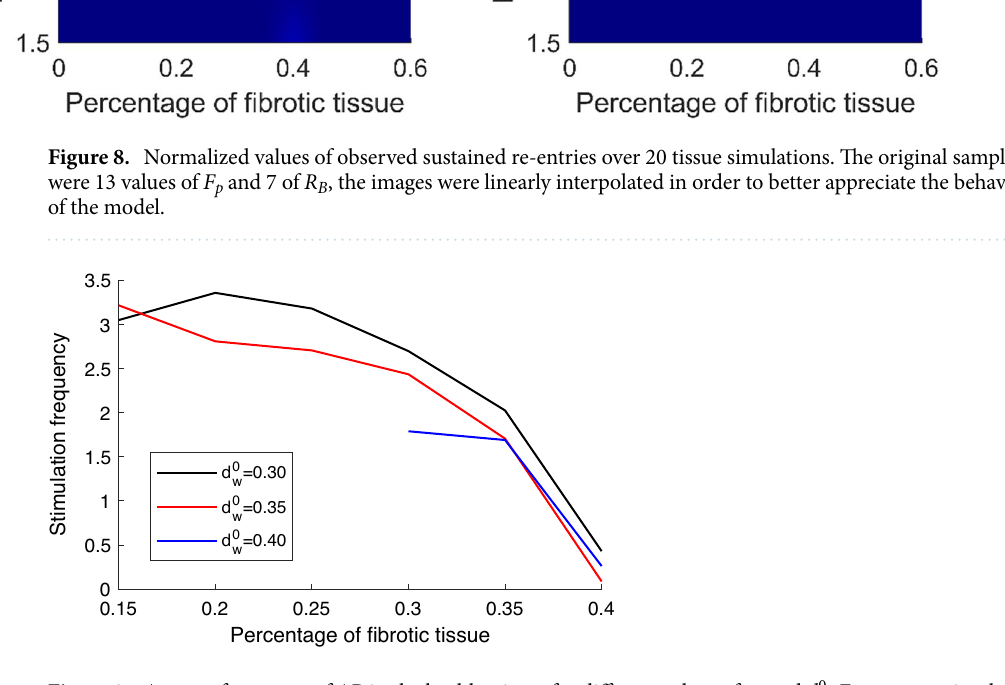
Figure 9. Average frequency of AP in the healthy tissue for different values of F p and d values were averaged across both the simulation runs and R B . Only the simulations showing sustained reentry were